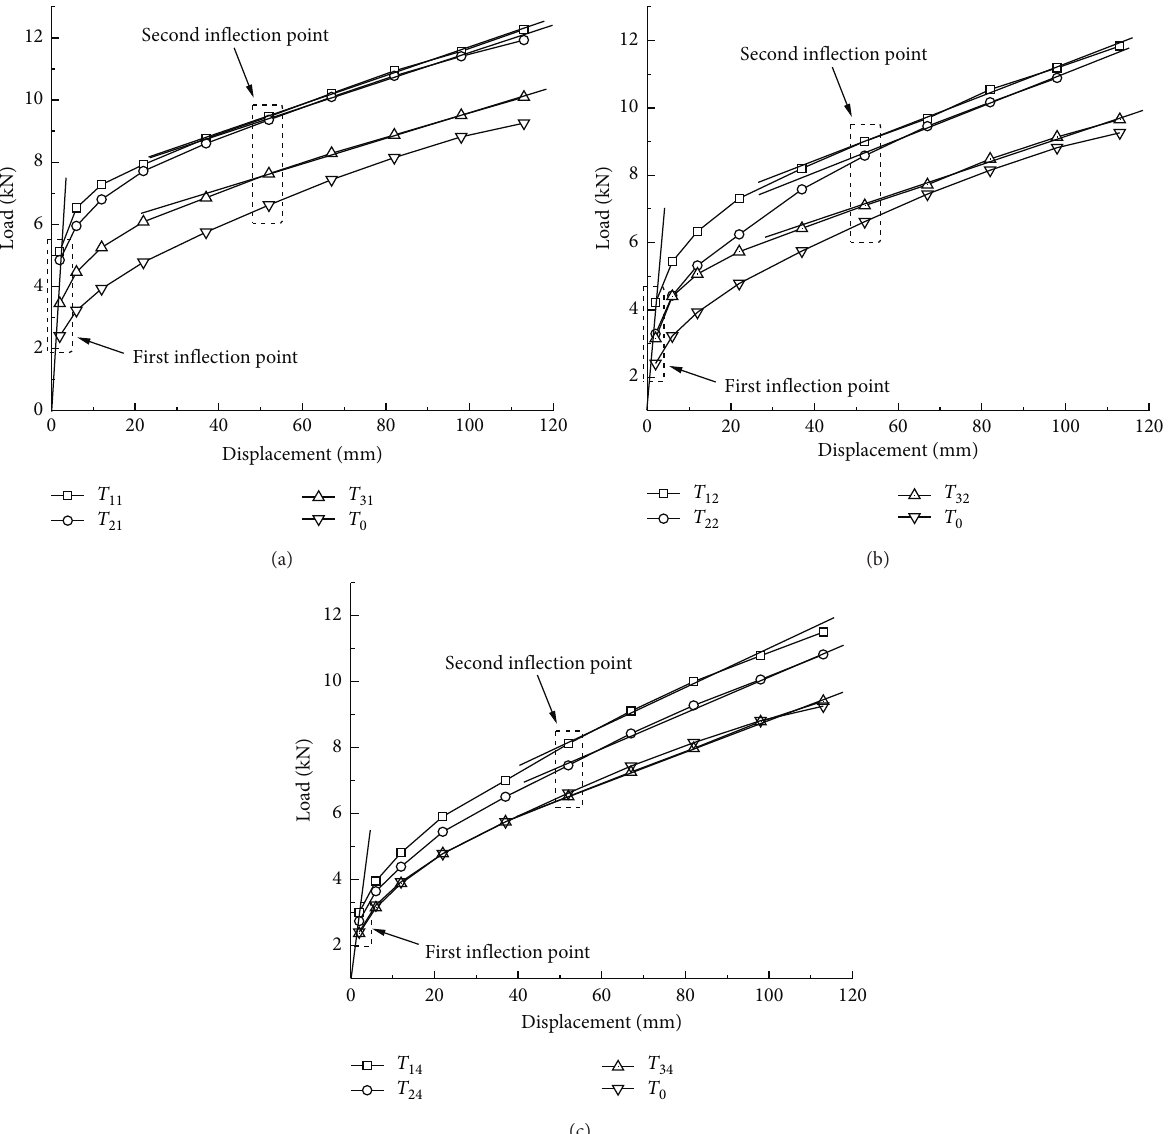
Figure 7: Uplift load and displacement curve with different reinforcement materials. (a) Layout spacing 50 mm. (b) Layout spacing 100mm. (c) Layout spacing 200